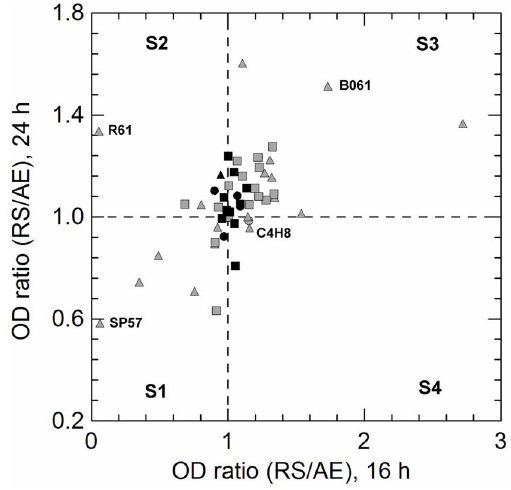
Figure 3. Distribution of L.casei (circles), L.paracasei (triangles) and L. rhamnosus (squares) strains on the basis of biomass production at 16 h (X-axis) and 24 h (Y-axis) under aerobic (AE) and respiratory (RS) growth. Graphs were divided in 4 sections by dashed lines to better represent the strains whose growth was stimulated (OD ratios higher than 1) by heme and menaquinone supplementation. Black symbols show the strains capable to consume oxygen (measurement with resazurin assay). The labels for strains which were used for growth kinetic studies are shown.